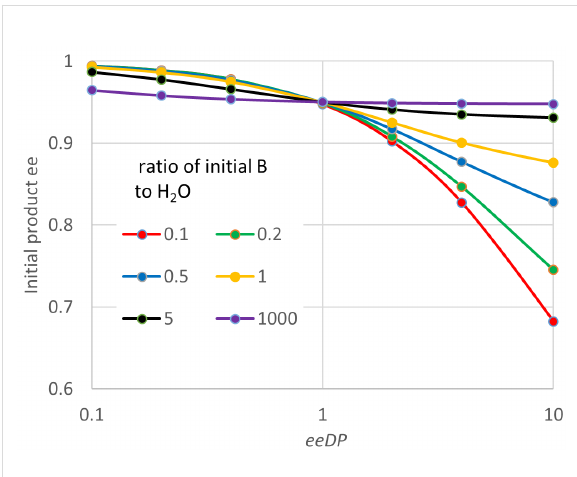
Figure 9: Effects on the ee of the product formed early in the reaction for “ping-pong, both” kinetics, diacid esterification. The graph plots ee at a conversion of about 0.1. For this plot the value of eeDP was altered by varying SCSf / b , but very similar ee values were found if SCRf / b or E2 / E were varied instead. Similarly, Q 0 (the initial H 2 O con- centration) was varied for the plot, but the ratio B 0 / Q 0 is what actually determines the behaviour. Parameters not varied were: S 0 = 0.2 M, B 0 = 0.4 M, K eq = 10, E = 39, K S = 0.1 M, k 2R = 1000 s − 1 , SCRf / b = 0.5, E2 / E = 0.5, SCR2f / SCRf = 1, k 4R / k 2R = k 2R / E · k 2S = k 4R / E · k 4S = 1, k − 1R / k 2R = k − 1S / k 2S = k − 3R / k 4R = k − 3S / k 4S = 2.